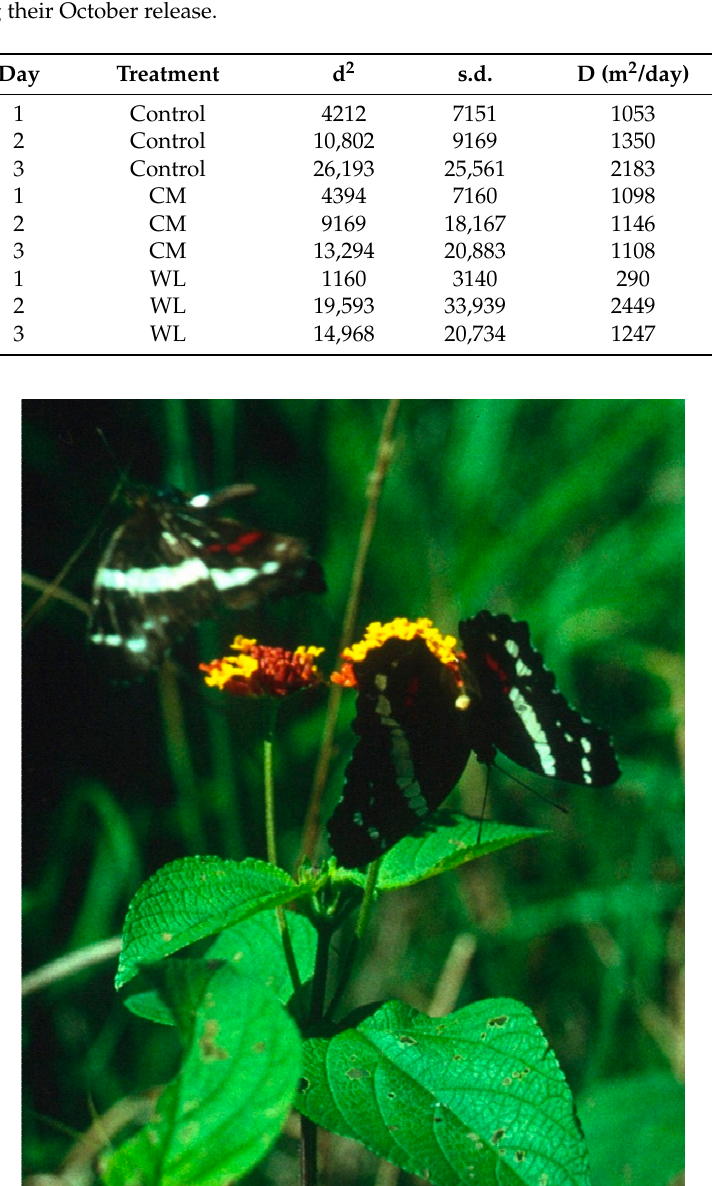
Figure 3. A control A. fatima male courts a CM female on a Lantana flower.